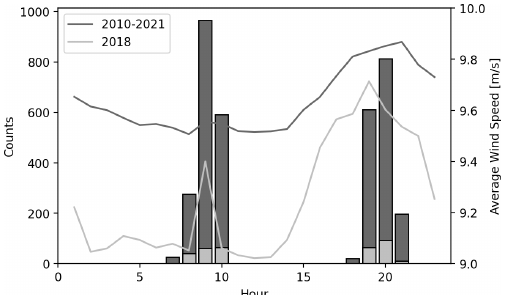
Figure 10. Number of hourly ASCAT observations (bars) at the FINO3 site for 2010–2021 (dark grey) and 2018 (light grey) in UTC. Mean hourly FINO3 wind speed at 107m (lines) for 2010– 2021 (dark grey) and 2018 (light grey).